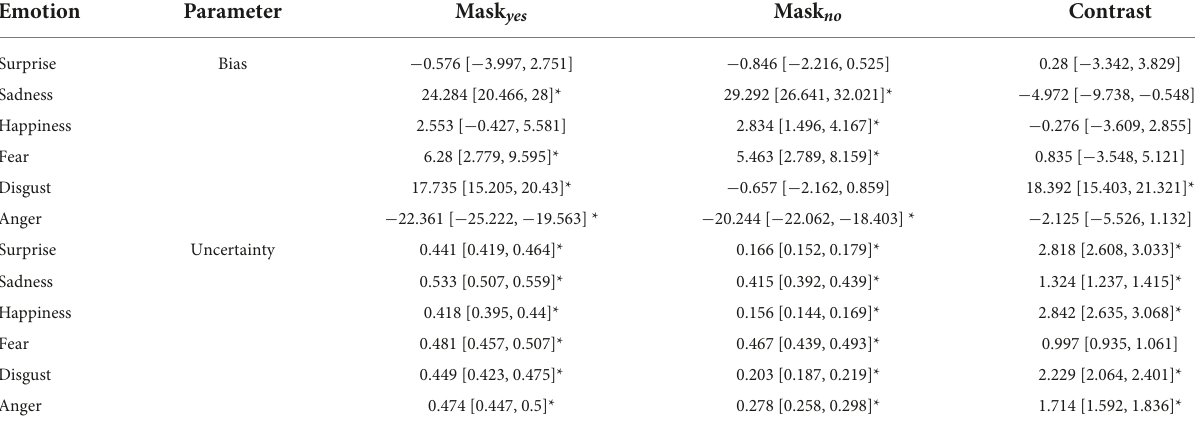
TABLE 1 Posterior distribution summaries for the bias and uncertainty Mask effect as a function of the displayed Emotion.